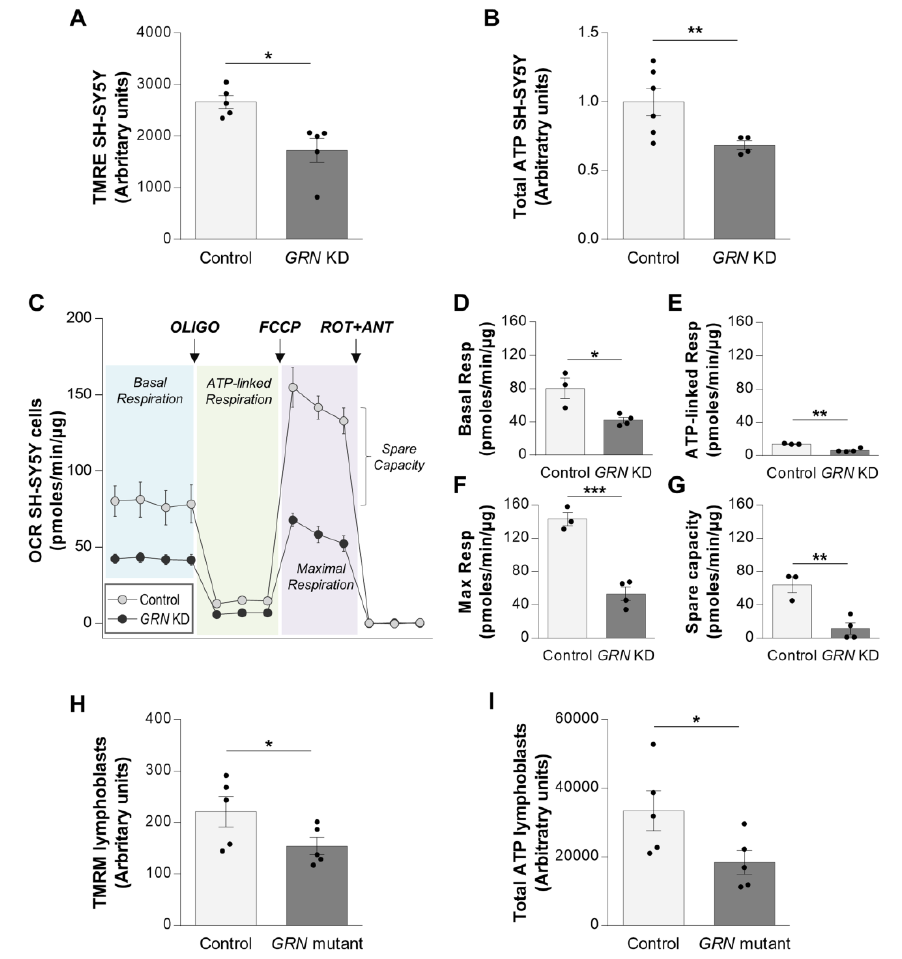
Figure 2. PGRN insufficiency reduces mitochondrial membrane potential, decreases ATP production and impairs mitochondrial respiration in SH-SY5Y cells and FTLD-TDP patients’ derived lym- phoblasts. ( A ) Control and GRN KD SH-SY5Y cells were seeded in triplicate at the same confluency (50,000 cells/well) on 96-well plates and 48 h later cells were labeled with TMRE for 30 min to assess the mitochondrial membrane potential. TMRE fluorescence was measured using a plate reader (Ex/Em = 549/575 nm). Plot represents the average ± SEM of five independent experiments. ( B ) Total ATP measurements in control and GRN KD SH-SY5Y cells using a fluorescent FRET-based ATP- plasmid indicator. Fluorescent measurements were performed using a confocal microscope and a 63× oil-immersion objective (Ex/Em cyan = 405/460-510nm; Ex/Em yellow = 405/515-580nm). Plot represents average ± SEM of ATP measurements in control and GRN KD cells. ( C ) Plot summarizing the averaged traces of oxygen consumption rate (OCR) measurements in control and GRN KD SH- SY5Y cells, performed using Seahorse XF24 Extracellular Flux Analyzer (Oligo: Oligomycin; FCCP: Carbonyl cyanide 4-(trifluoromethoxy)phenylhydrazone; ROT: Rotenone; ANT: Antimycin). ( D – G ) Individual plots showing the average ± SEM of basal respiration (basal resp), ATP-linked respiration (ATP-linked Resp), maximal respiration capacity (Max Resp Capacity) and Spare capacity. ( H ) Lym- phoblasts derived from five healthy individuals and five FTLD-TDP patients carrying a LOF muta- tion in the GRN gene were seeded in triplicate at 1x10 6 cells/mL and 48 h later the mitochondrial membrane potential was measured by measuring TMRM fluorescence using a plate reader (Ex/Em = 549/575 nm). Plot represents the average ± SEM of TMRM fluorescence in all individuals. ( I ) Plot summarizing the measurement of ATP levels in lymphoblastoid cell lines generated from five healthy individuals and five FTLD-TDP patients carrying the same LOF GRN mutation.